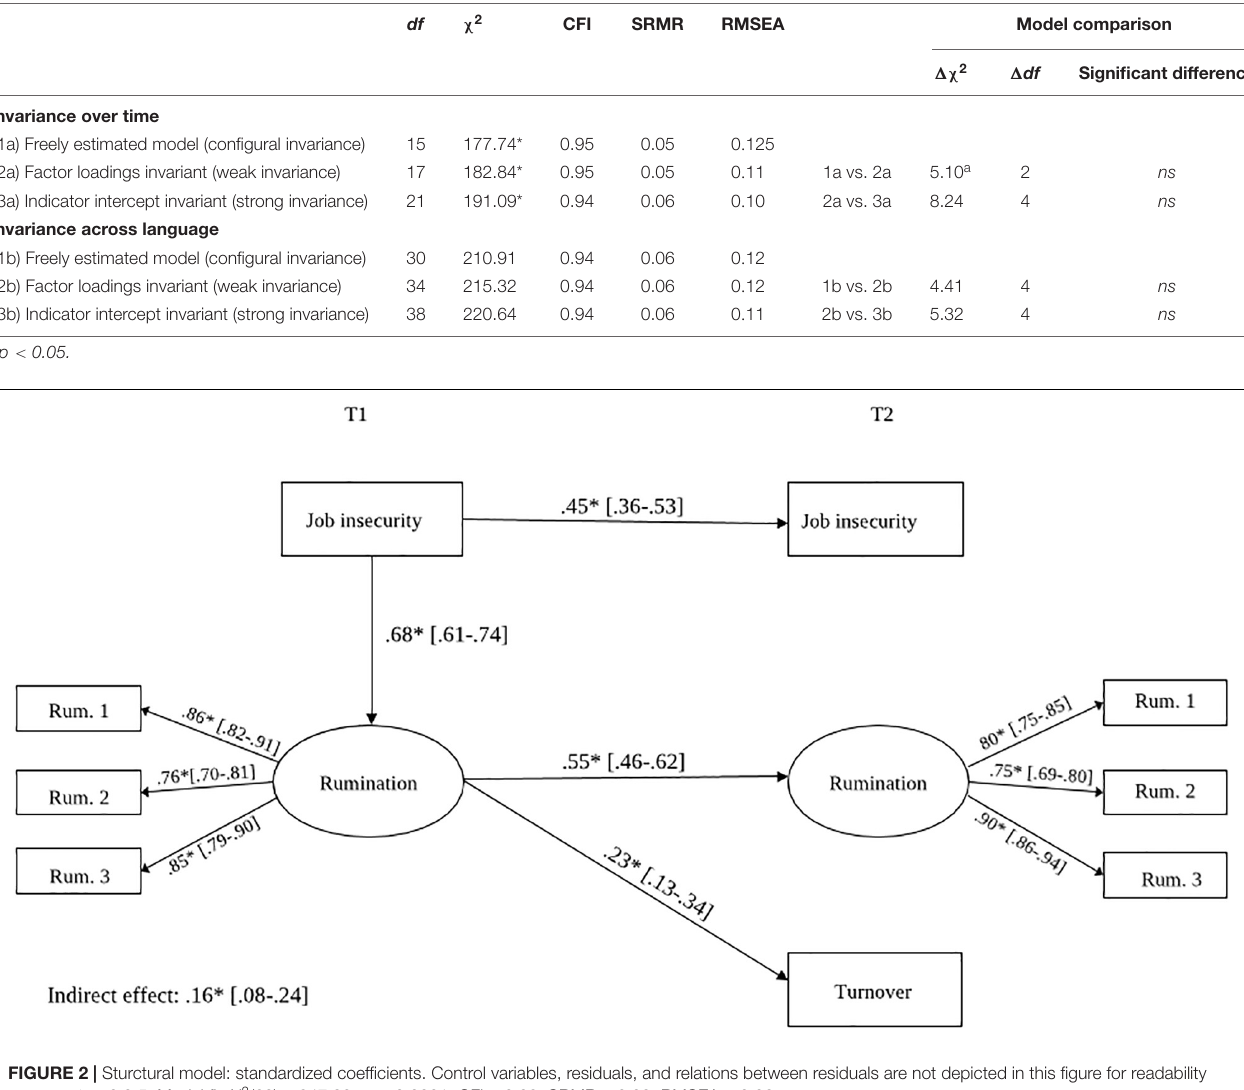
FIGURE 2 | Sturctural model: standardized coefficients. Control variables, residuals, and relations between residuals are not depicted in this figure for readability reasons. ∗ < 0.0.5, Model fit: X 2 (60) = 247.83, p < 0.0001, CFI = 0.83, SRMR = 0.08, RMSEA = 0.06.